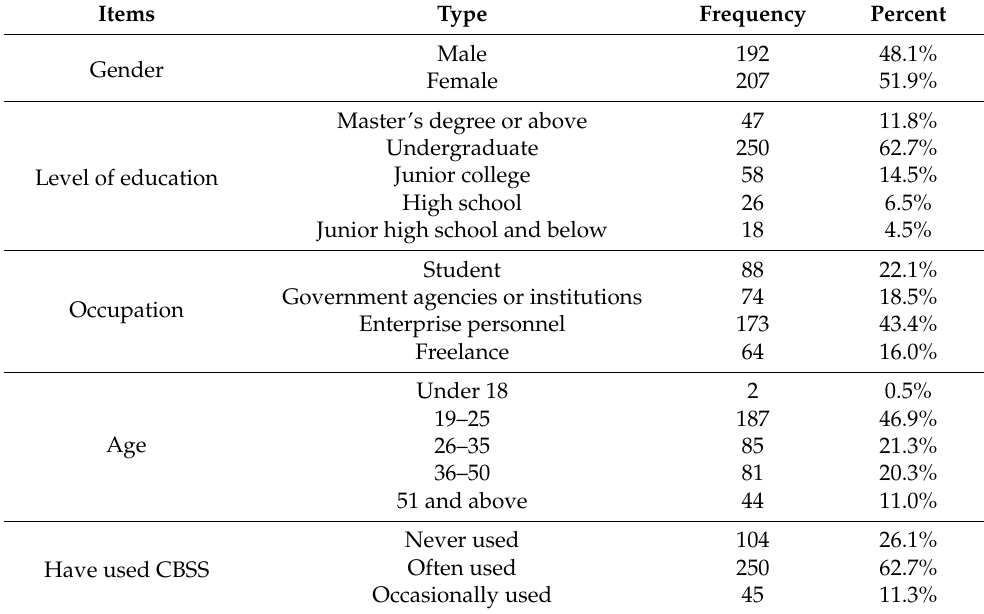
Table 3. Demographic characteristics of the